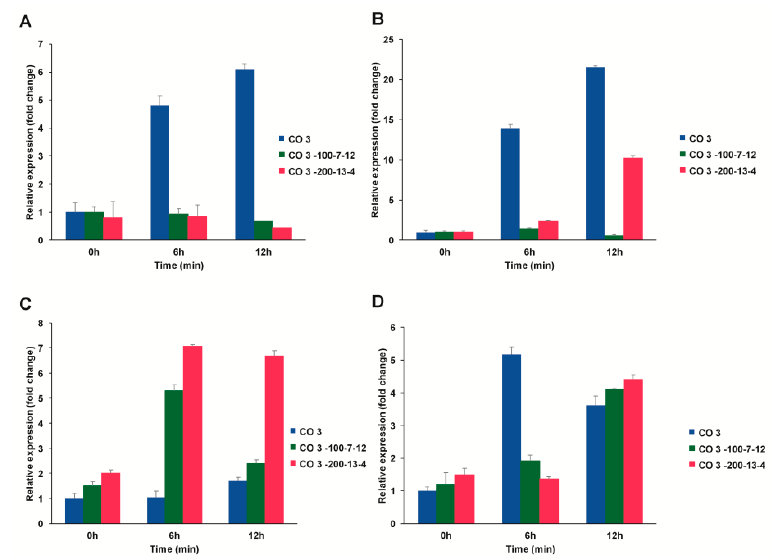
Figure 10. Relative expression profile of ( A ) NADP-MDH1 , ( B ) NADP-MDH4 , ( C ) NADP-MDH10 , and ( D ) NADP-MDH11 genes analyzed using qRT-PCR under dehydration stress for 0 h (control), 6 h (early) and 2 h (late) in 21-day-old seedlings of CO 3, CO 3-100-7-12, and CO 3-200-13-4.